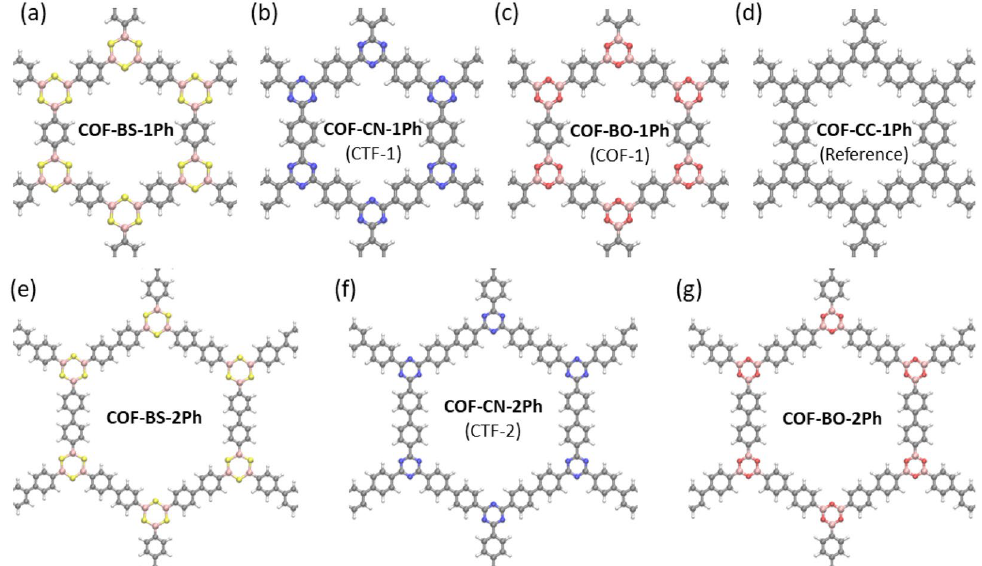
Figure 1. 2D COF structures with different linkers and phenyl ( a – d ) or biphenyl spacing units ( e – g ). Structure ( d ) serves as an idealized reference system for comparison. Chemical elements are represented with different colors: boron (pink), carbon (gray), hydrogen (white), nitrogen (blue), oxygen (red) and sulfur